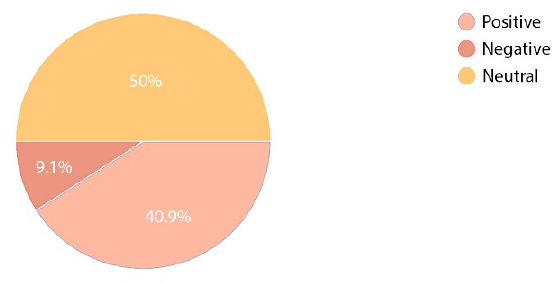
Figure 10. Perception of stay at the hospital—staff .